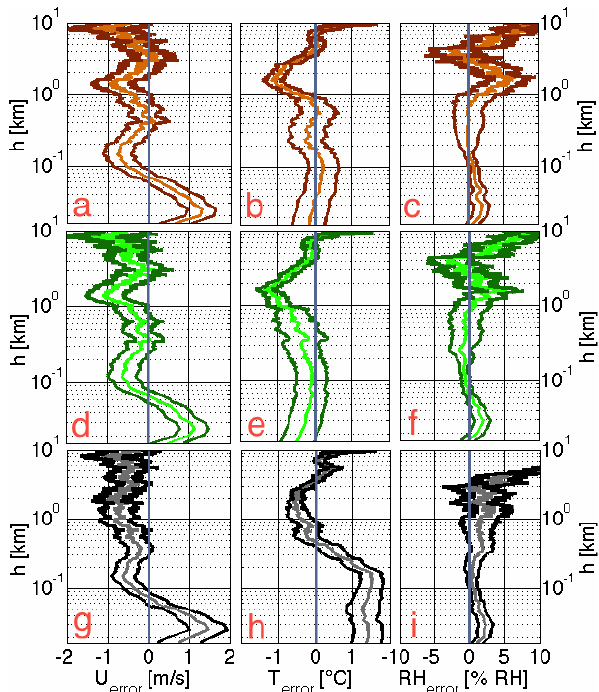
Fig. 7. The mean error of the vertical structure as a function of al- titude (km) comparing reanalyses to soundings from (a–c) ASR1, (d–f) ASR2 and (g–i) ERA-Interim. The different panels show (a, d, g) scalar wind speed inms − 1 , (b, e, h) temperature in ◦ C, and (c, f, i) relative humidity in percent. The lighter-colored middle line is the median difference between reanalysis and observation, while the darker lines are the ± the 95% significance interval. Note the logarithmic vertical